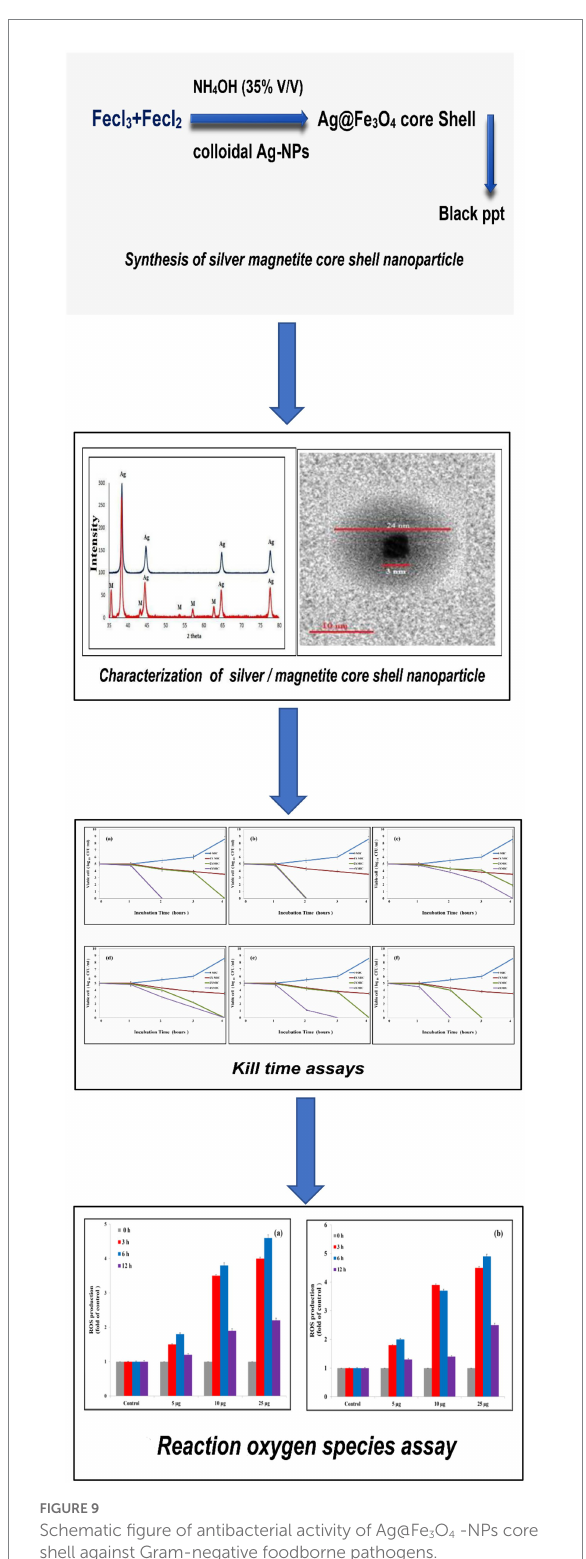
FIGURE 9 Schematic figure of antibacterial activity of Ag@Fe 3 O 4 -NPs core shell against Gram-negative foodborne